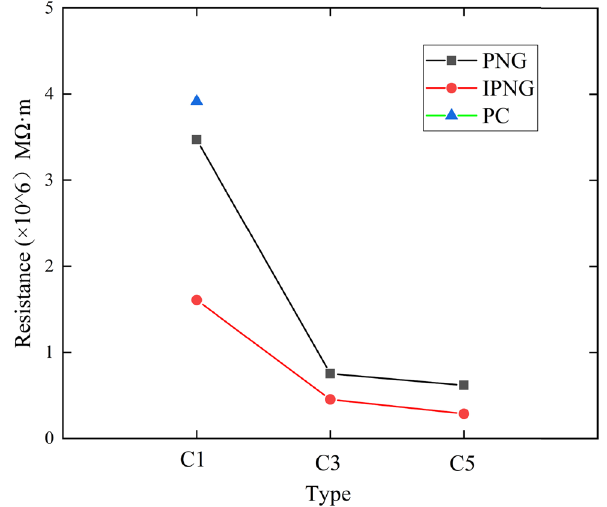
Figure 5: Results of electrical